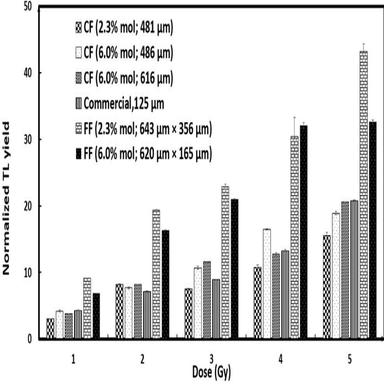
The sensitivity of FGDOFs and commercial optical fibres for 6 MeV electrons.